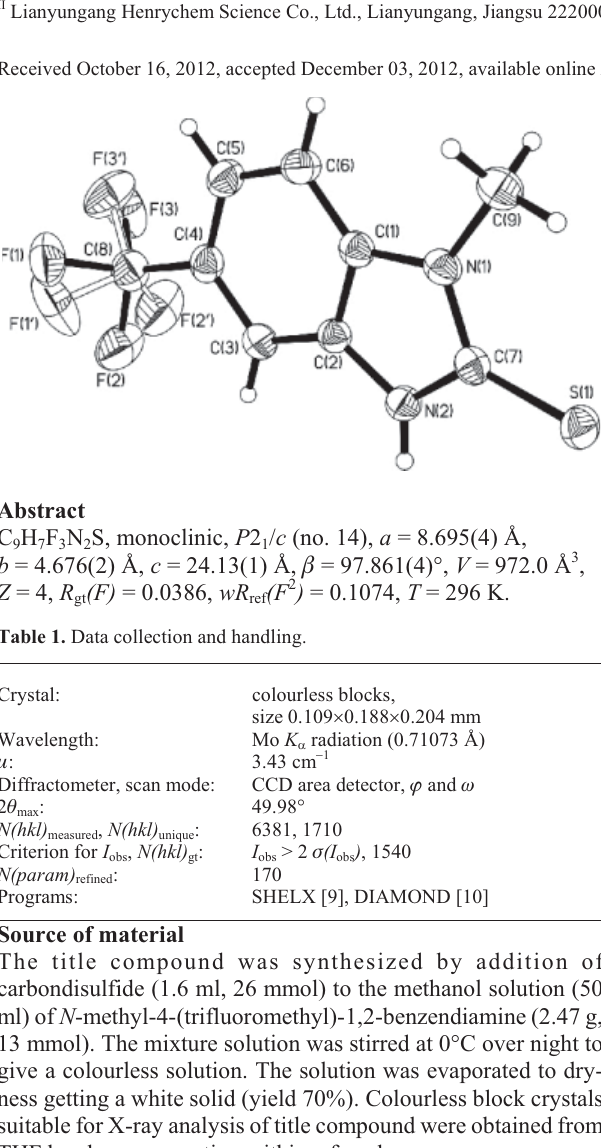
title compound in the solid state prefers the thio form with N2 protonted rather than the alternative tautomeric ene-thiol form [4-